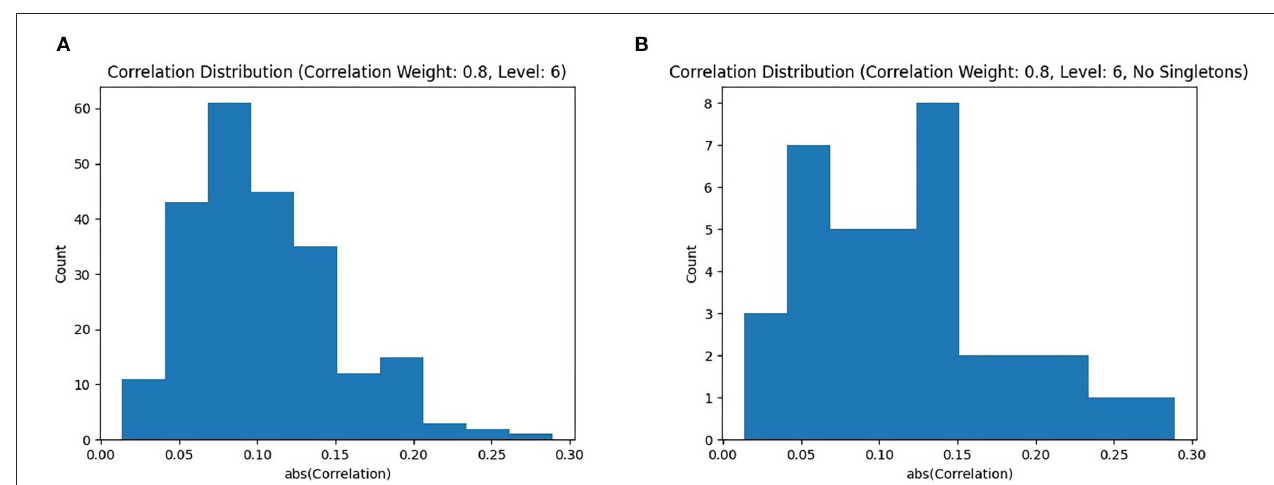
FIGURE 4 | Correlated Louvain results: (A) shows a distribution of | ρ | produced by the Correlated Louvain method with k 4 = 0.8; (B) shows the same distribution but with singleton clusters removed, only showing subgraphs with | V | ≥ 2.